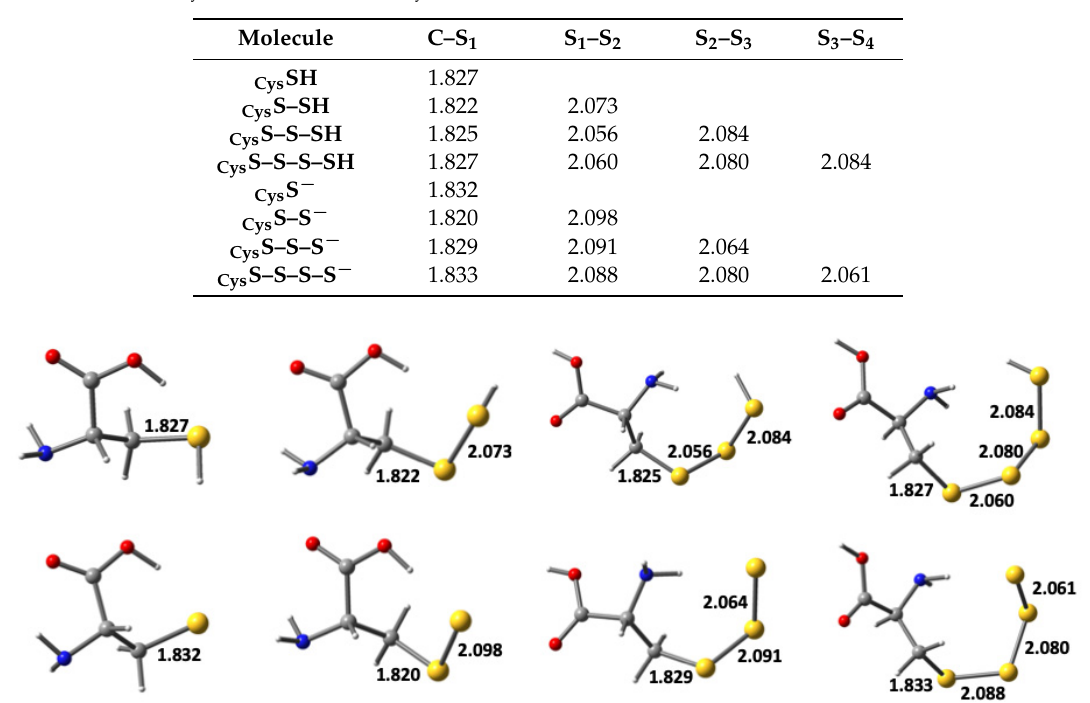
Table 8. Selected optimized bond lengths in ångström (Å) obtained at the ω B97XD/6-311G(2d,p) level of theory for Cys SS n H ( n = 0–3) and Cys SS n − ( n = 0–3).